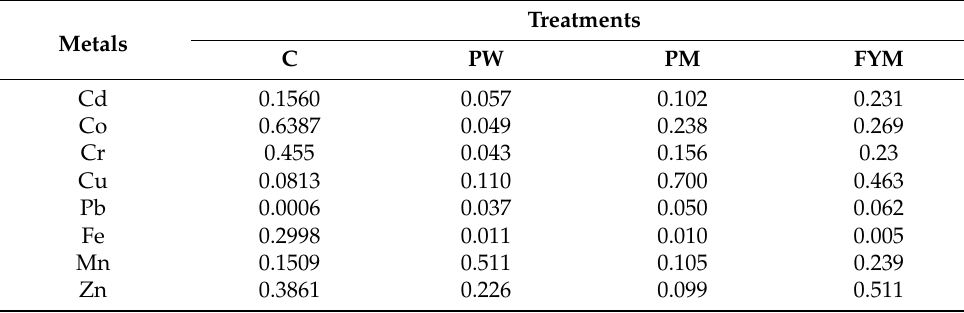
Table 4. Pollution load index for heavy metals in soil grown with A.